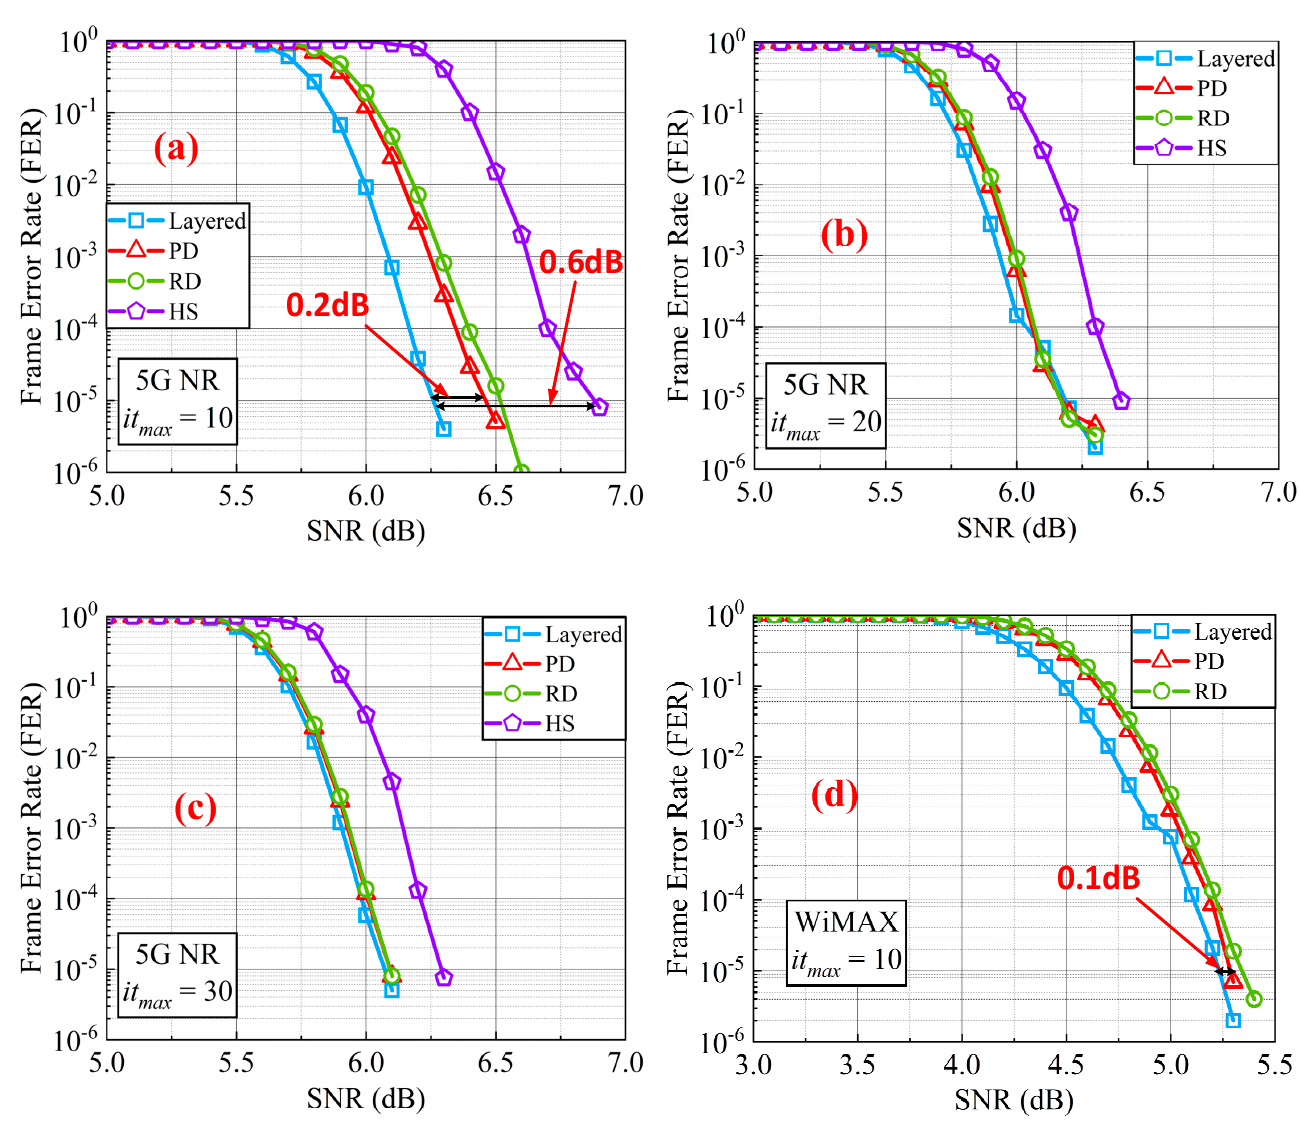
Figure 7. The SNR performance of different schedules with different maximum iteration numbers.